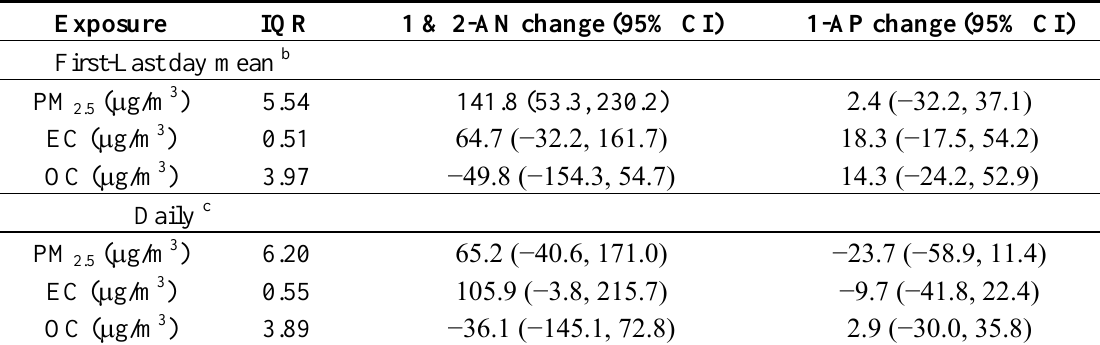
Table 2. Change in marker levels (pg/mg creatinine) and 95% confidence intervals associated with each IQR increase in pollutant exposure measurements a .